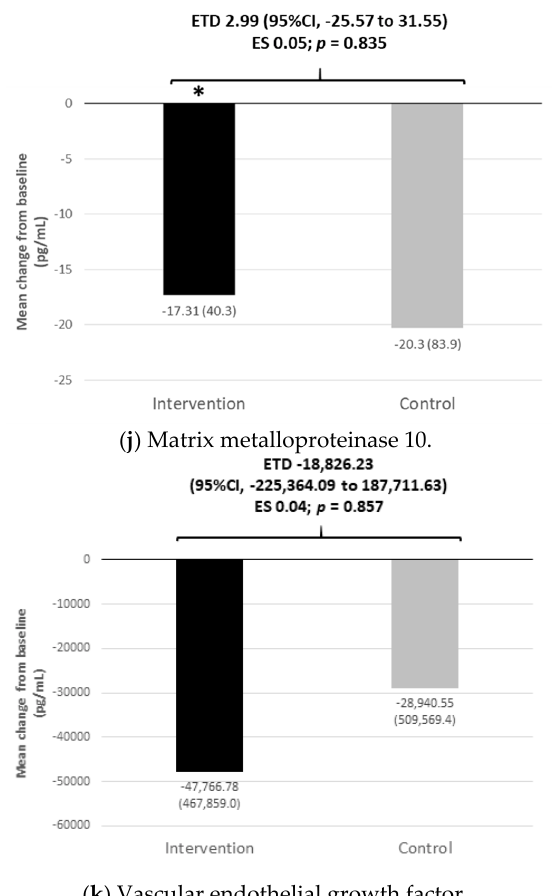
Figure 1. a–k. Inflammatory markers and angiogenic factors at month 12. CI, confidence interval; ETD, estimated treatment difference; ES, effect size (Cohen’s d). Figures between brackets are standard deviations. * p < 0.01 vs. baseline; ** p < 0.001 vs. baseline.